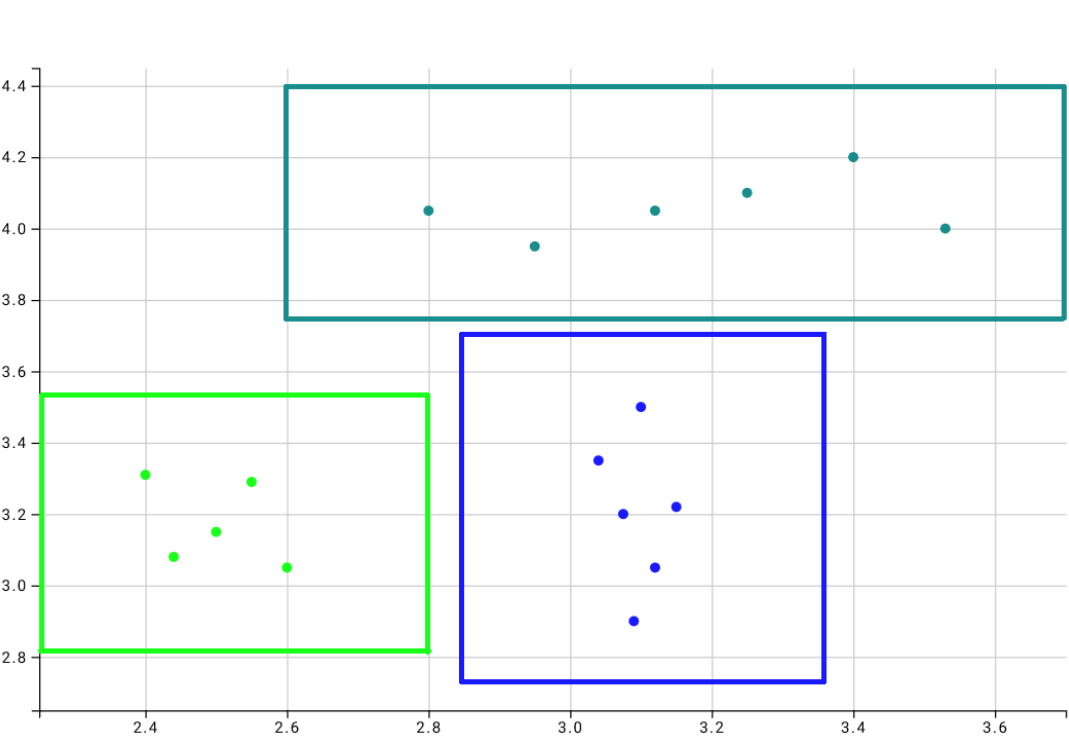
Figure 4. Rules found for a sample dataset. Each color represents one of three different classes. Each square represents a classification rule associated with its class’s color.